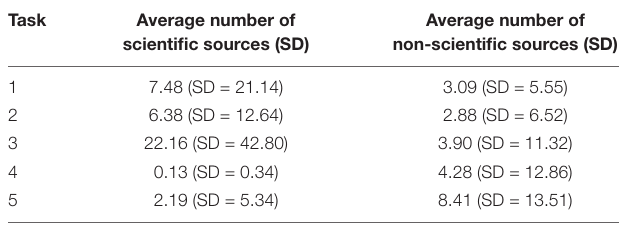
TABLE 3 | Number of accessed news websites by subtype and per task 1 .